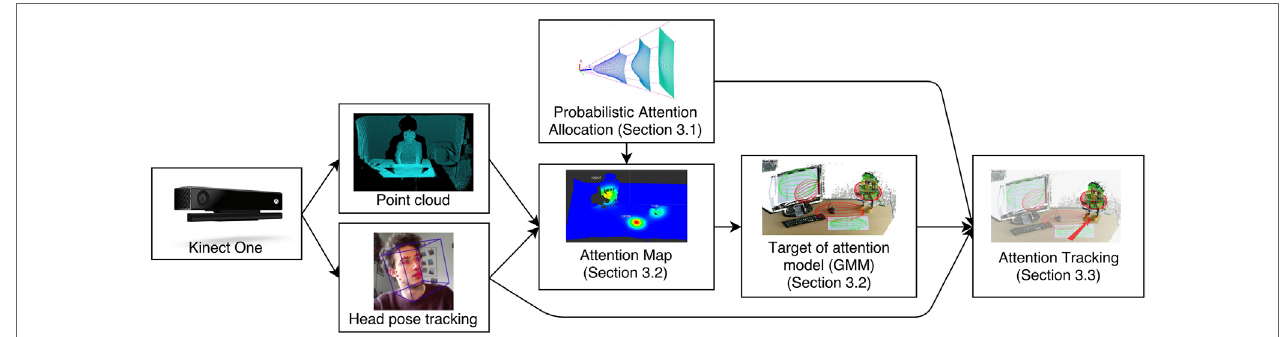
FigUre 1 | Overall scheme of the proposed